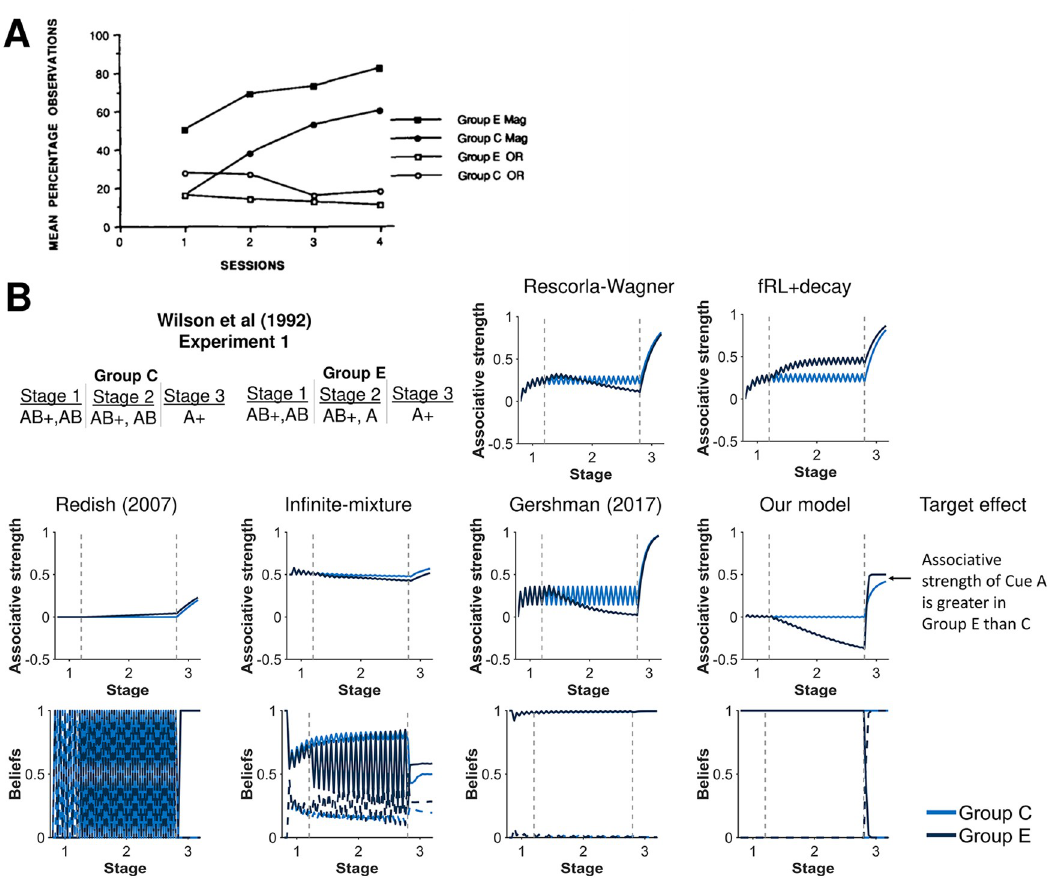
Fig 3. Associability depends on latent-state beliefs. A) Experimental results from Stage 3 of the Wilson et al (1992) experiment [27]. Group E had higher magazine activity, i.e. greater responding, than Group C during the light (Cue A) in Stage 3. Thus, it was believed the light had greater associative strength in Group E than Group C during Stage 3. Reprinted from Paul N. Wilson, Patrick Boumphrey, & John M. Pearce, Quarterly Journal of Experimental Psychology 44:1 pp. 17-36. Reprinted by Permission of SAGE Publications, Ltd. B) Simulation of associative strength of the light (Cue A) and latent state beliefs from the Wilson et al (1992) experiment. Our model predicts that only Group E detects the change in experimental conditions and shifts their beliefs. Because of this shift, associability is higher in Group E than C during Stage 3, leading to higher associative strength of the light. Beliefs in the first latent state (dark and light blue solid lines) and the second latent state (dark and light blue dashed lines) are shown for models with latent states. Gray dashed lines demarcate experimental